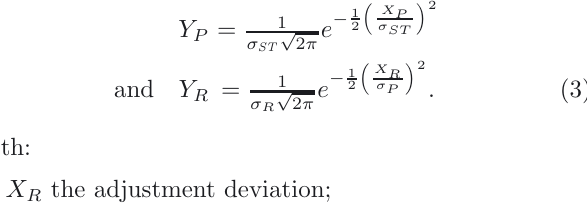
Figure 2 applies to small samples from 1 to x measures. The Gaussian curves represent the average distribution